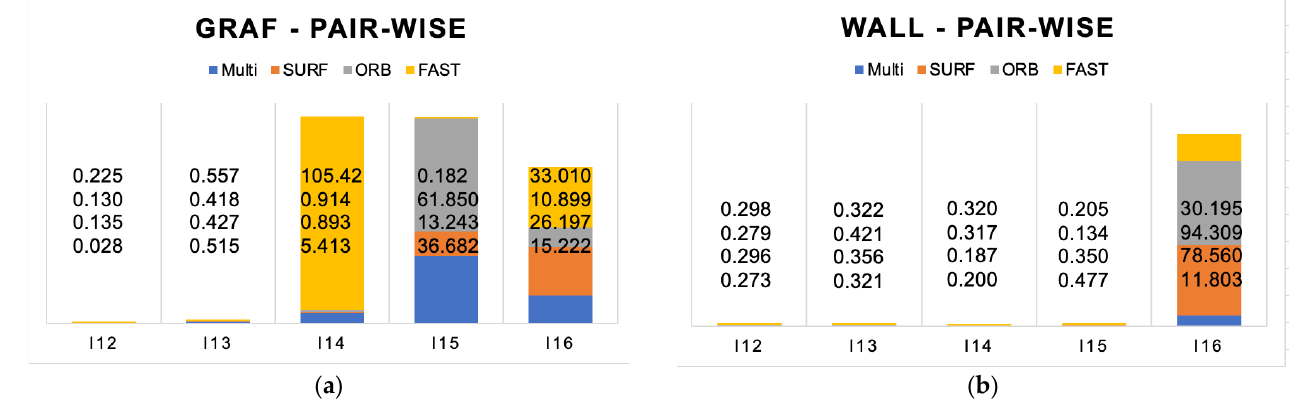
Figure 9. Pairwise RMSE [m] evaluation of H-matrix estimation of Graf ( a ) and wall ( b ). The average RMSE evaluation of H-matrix estimation and the average number of features detected for both, Graf and wall, are summarized in Table 4. SURF realizes on the Graf scene on average RMSE 8.18 m and detect 1675 pt. This study’s multiple FDO approach achieves 11.57 m ( −3 .39 m) and detects 3032 pt (+81%) points. For the Wall case, FAST realizes 6.27 m and detects 1 4′ 970 pt, whereas this study’s multiple FDO approach achieves 2.62 m (+3.65 m), and detects 18,443 pt (+19%). Table 4. Graf and wall average RMSE [m] and the average number of features detected. AVG RMSE [m] Features AVG RMSE [m]